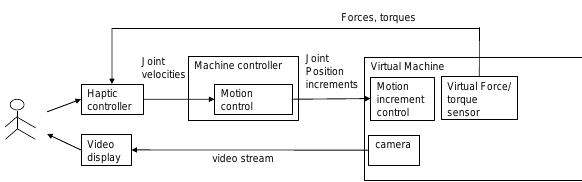
Figure 6: Remote haptic control of a virtual mobile machine.